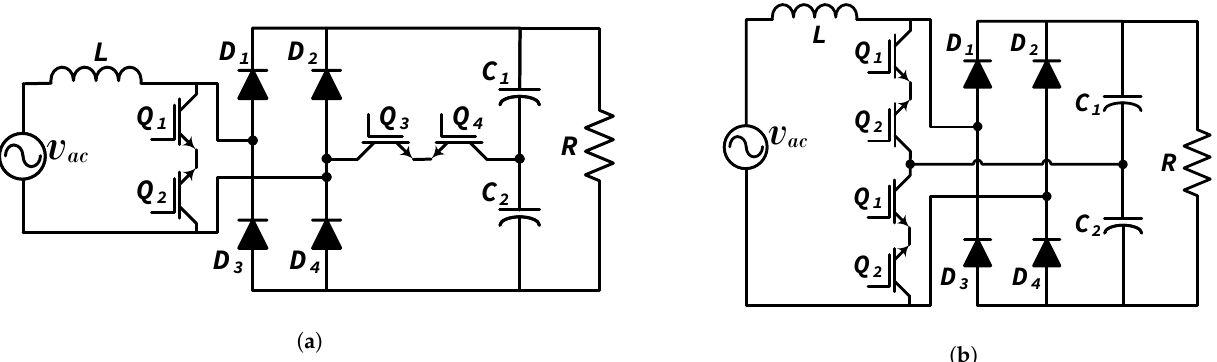
Figure 6. BBC converter with bidirectional switch: ( a ) bidirectional and flexible switches; ( b ) bidirectional and interleaved. Bidirectional switch topologies are only suggested for low voltage and low power